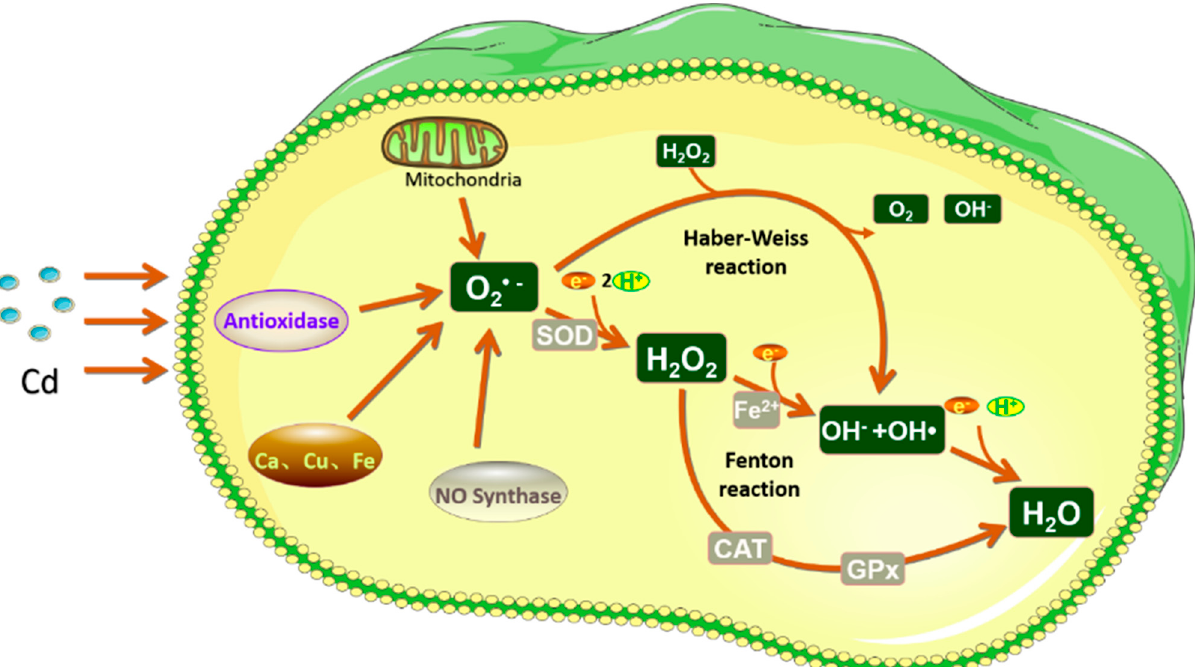
Figure 2. Schematic diagram of ROS metabolism and oxidative stress induced by Cd. Under normal physiological conditions, the ROS in the body are mainly converted into less toxic or harmless substances by antioxidant enzymes, such as superoxide dismutase (SOD), catalase (CAT), and glutathione peroxidase (GPx), while under the condition of Cd exposure, a large amount of ROS are generated and destroy the antioxidant system in cells.